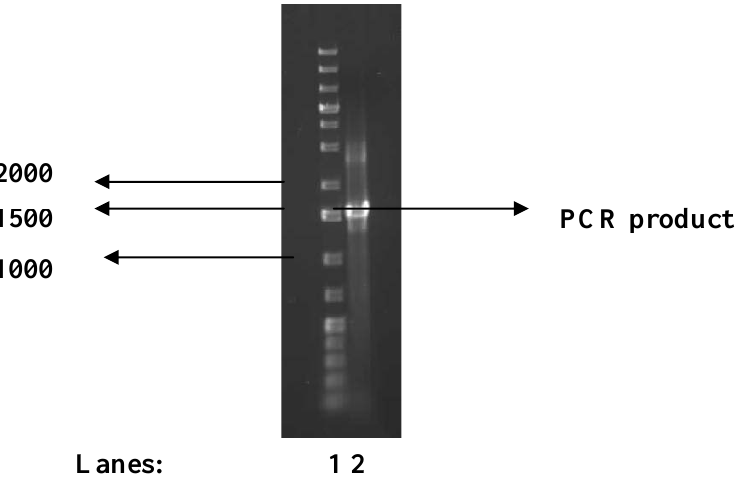
Figure 1. Agarose gel electrophoresis of PCR product of Halomonas sp. OKOH. Lanes: 1 = Ladders, 2 = PCR product.